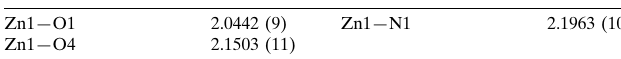
Selected bond lengths (A˚ ).